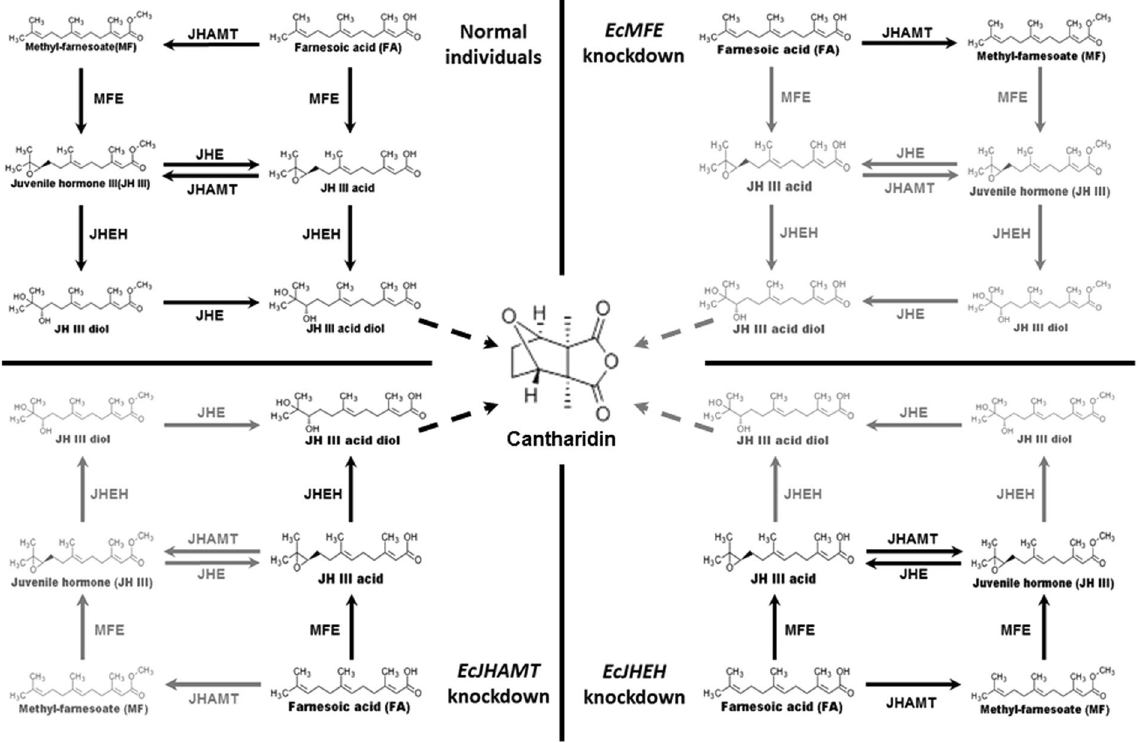
Figure 5. Diagram of the process of EcMFE , EcJHAMT and EcJHEH regulating cantharidin biosynthesis. Reactions that could occur normally are shown in black. Reactions that could not occur after dsRNA knockdown are shown in